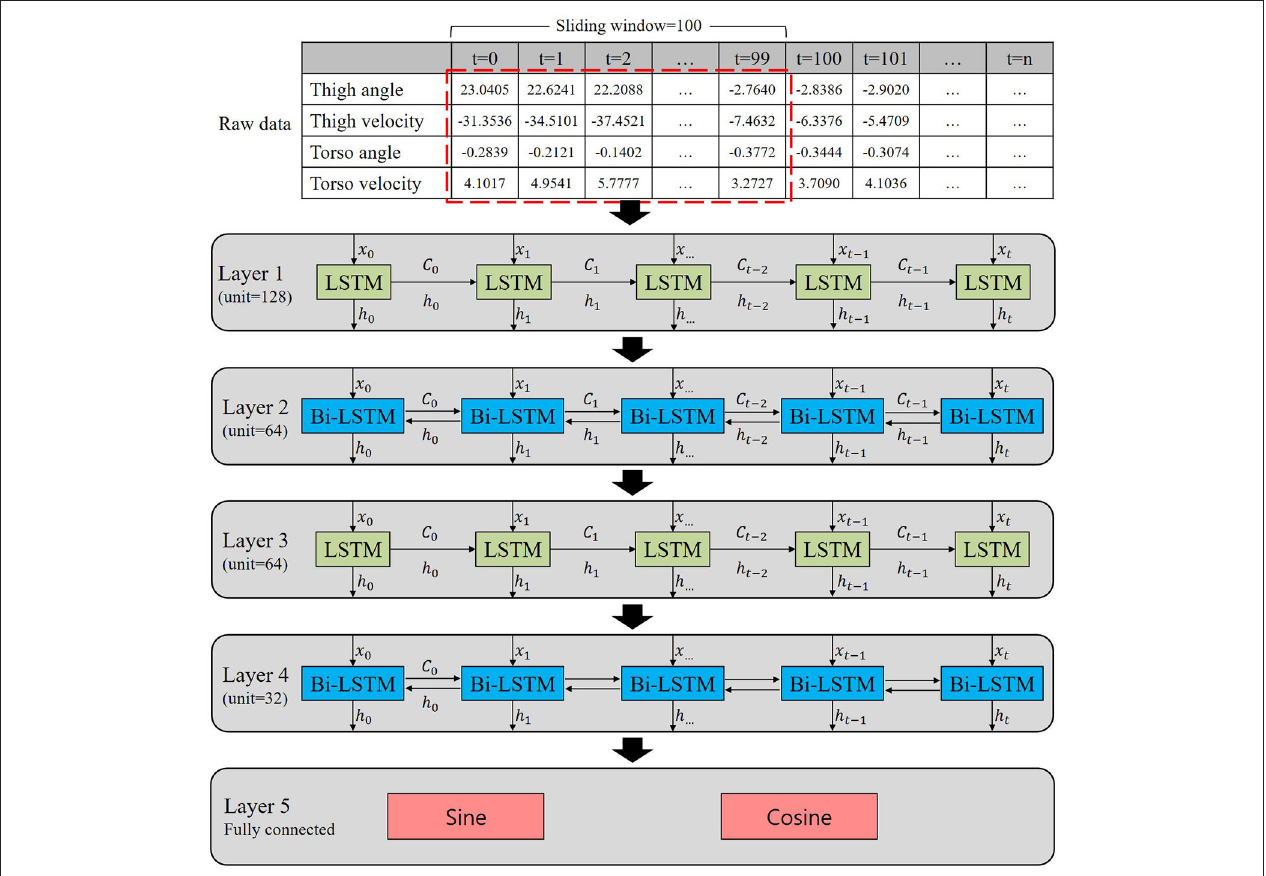
FIGURE 2 | Proposed neural network architecture for the gait phase estimation. The network consists of five layers with long short-term memory (LSTM) and bidirectional LSTM (Bi-LSTM). Layer 1–4 has 128, 64, 64, and 32 units, respectively. Layer 5 is fully connected and results in the output as sine and cosine functions.